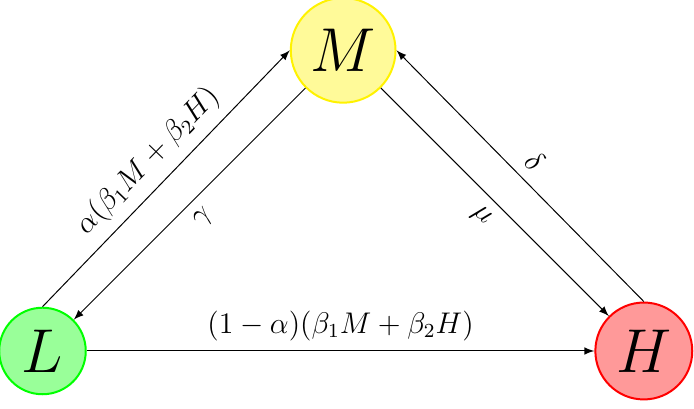
Figure 1. Illustration of the dynamic behavior of the LMH